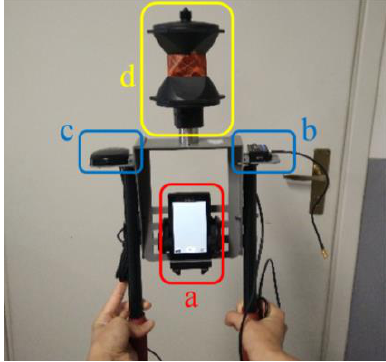
Figure 19 - The system used to acquire the data The result are shown in Figure 20, where the green line is the solution estimate with MEMS platform and using an integrated solution GNSS-IMU, where the GNSS data was available.